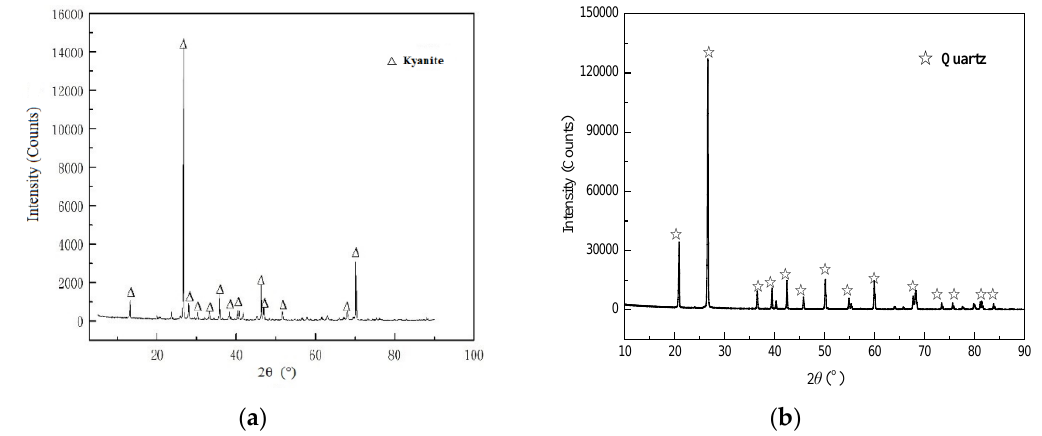
Figure 1. X-ray powder diffraction patterns of ( a ) kyanite and ( b ) quartz. Table 1. Chemical composition analysis of mineral samples (wt%).